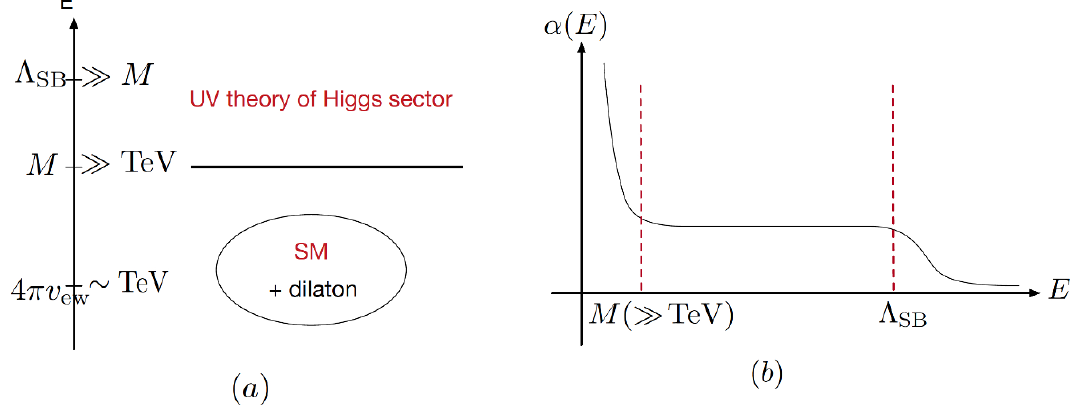
4 (cid:25)v ew , where the (cid:29) M . Below M , there is only one extra particle, (cid:29)